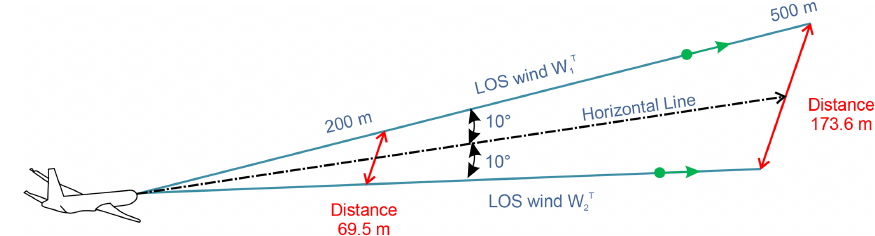
Figure 3. Distance to wind-field region between the lidars for two LOS distances.